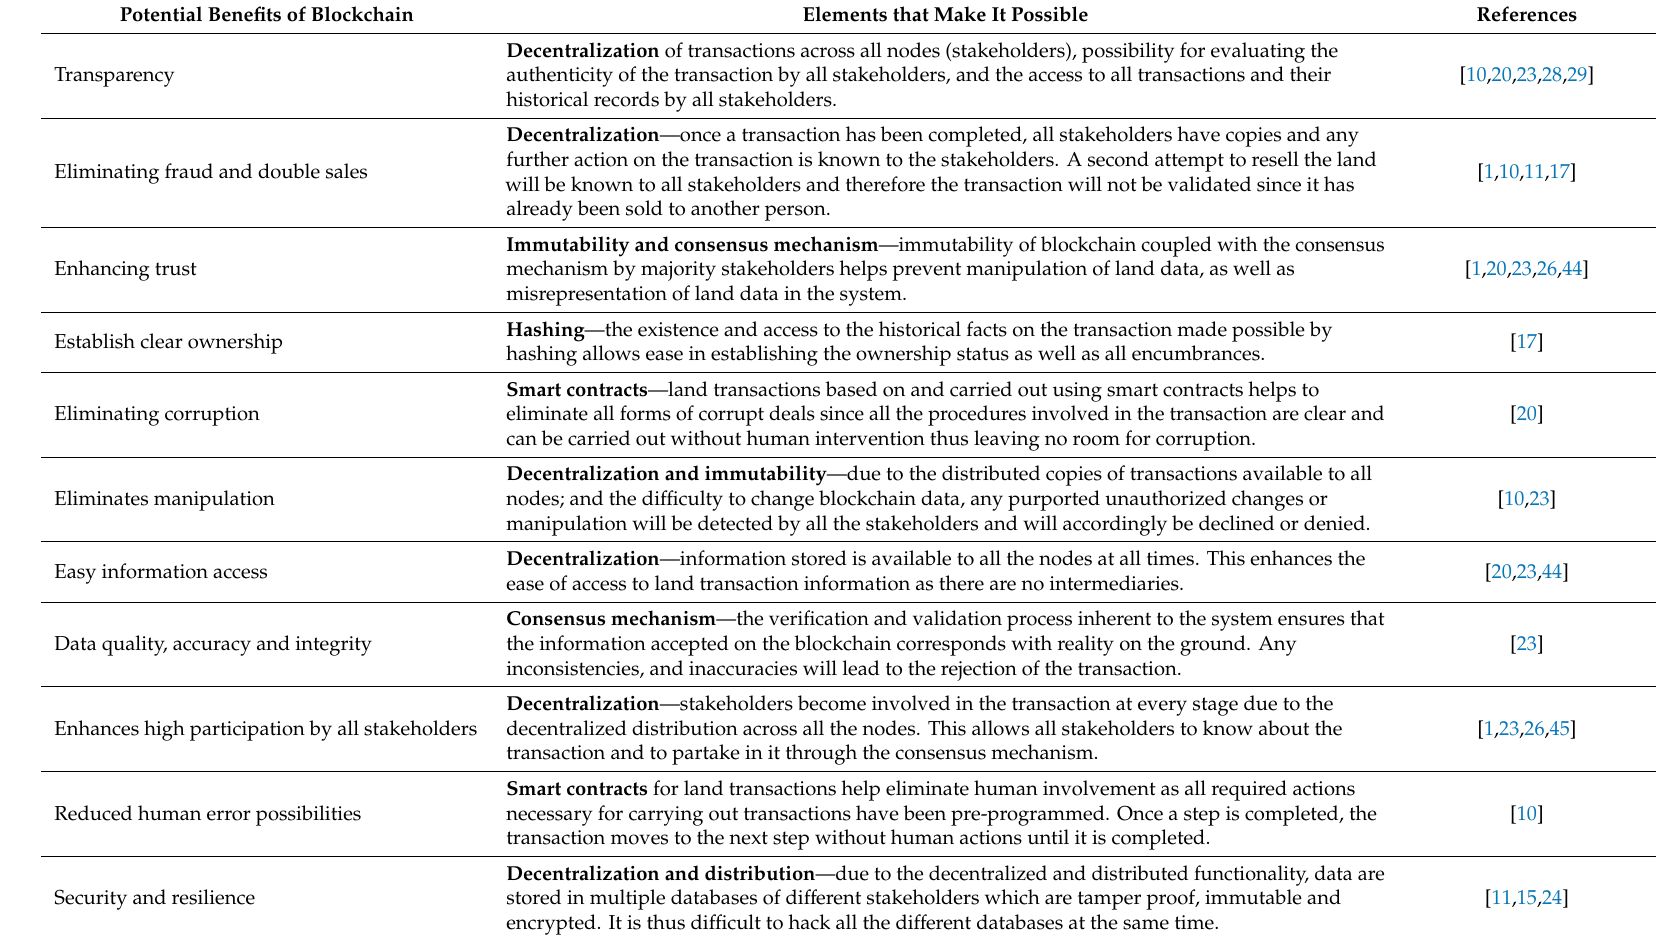
Table 2. Blockchain potentials to land administration Source: authors’